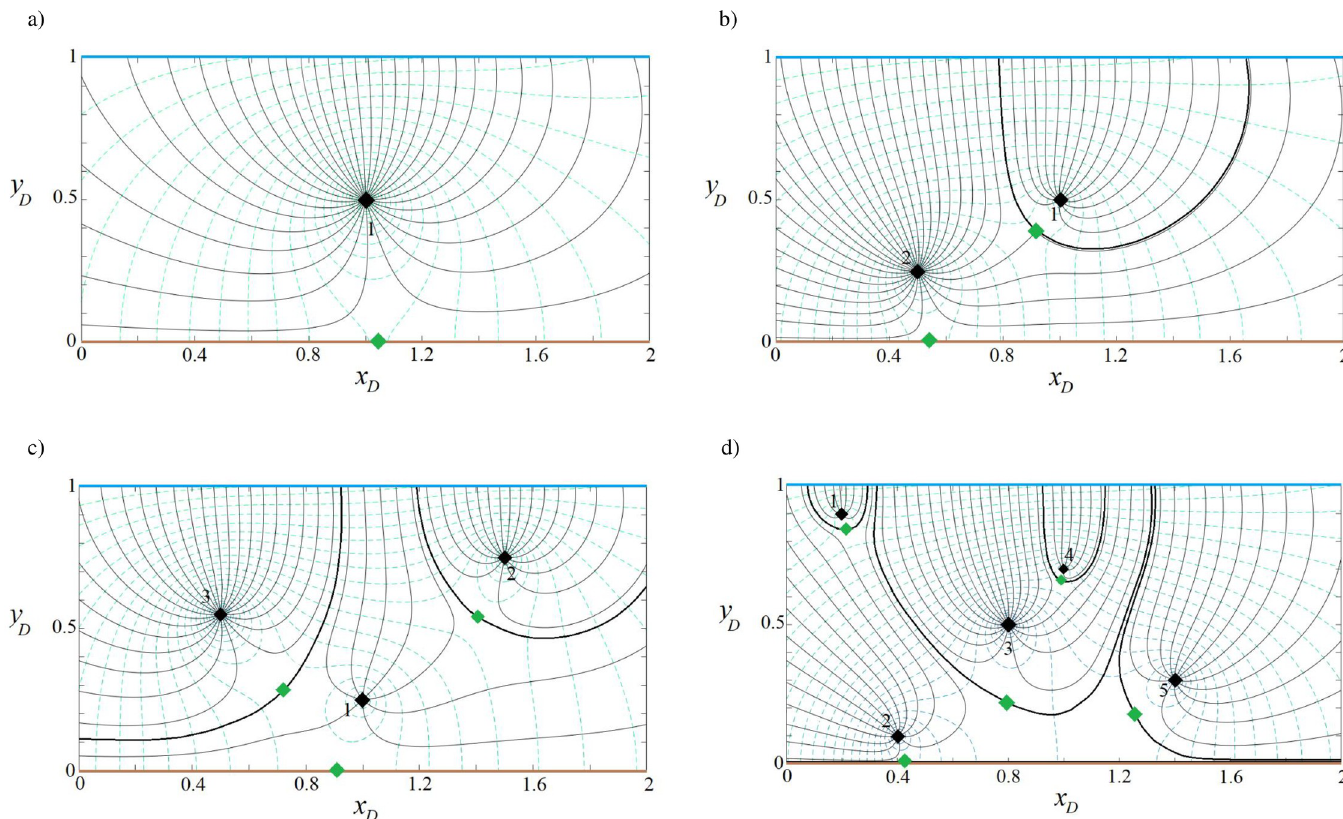
Fig 5. Velocity potential and stream function for one (a), two (b), three (c) and five (d) wells in a strip-shaped aquifer with inflow-barrier boundary